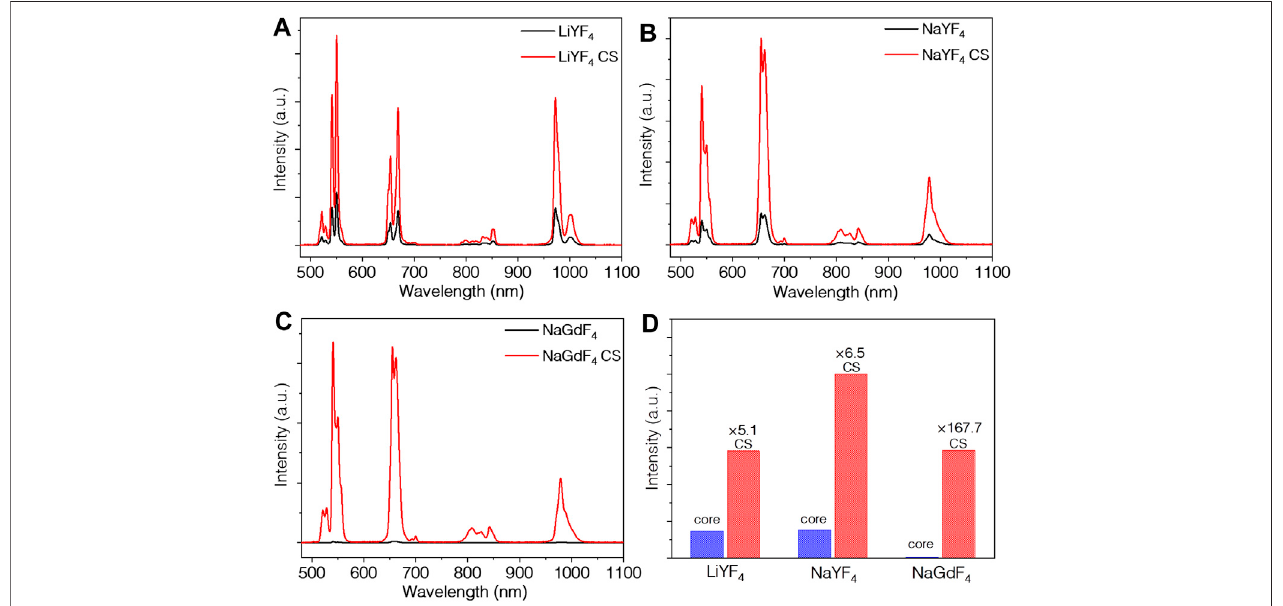
(B) NaYF (C) NaGdF 3+ and LiYF 3+ @LiYF 3+ and NaYF 3+ @NaYF 3+ and 4 :10%Er 4 :10%Er 4 , 4 :10%Er 4 :10%Er 4 , 4 :10%Er